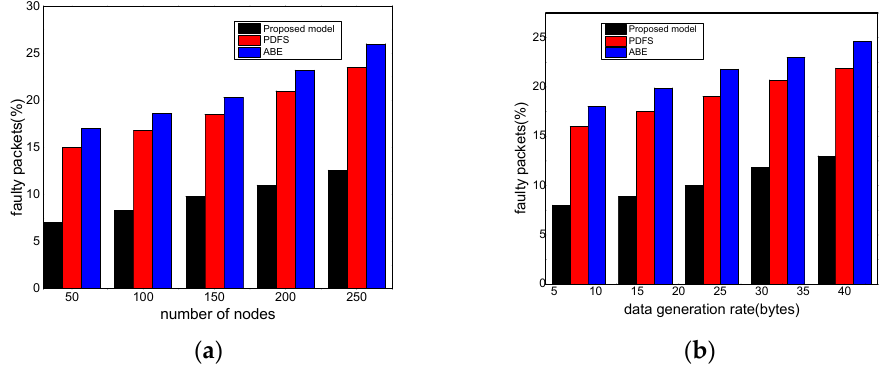
Figure 6. Performance of faulty packets with a varying number of nodes ( a ) and packet generation rate ( b ).